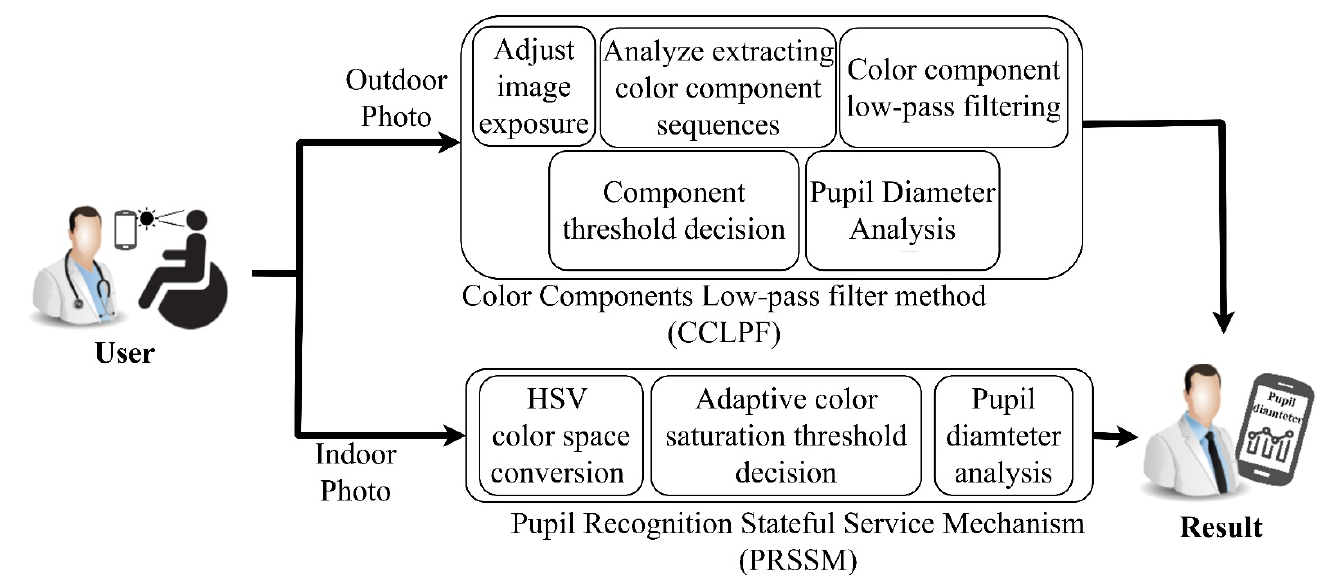
Figure 5. Schematic of the developed system for pupil diameter detection.